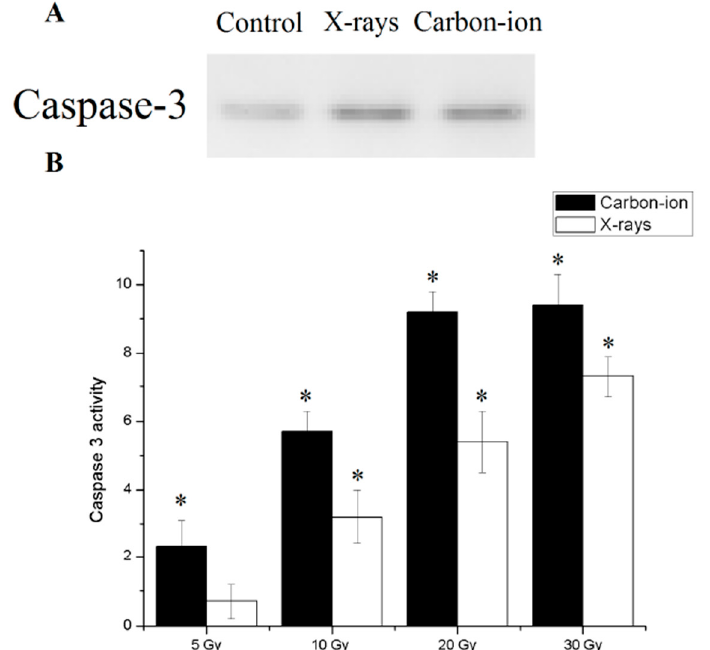
Figure 5. Apoptosis in 30 Gy X-rays and carbon-ion irradiated E. granulosus hydatid cysts. ( A ) Caspase 3 expression in hydatid cysts with and without 30 Gy ionizing radiation. ( B ) Caspase 3 like activity was measured as the difference in pNA production between the samples with and without ionizing radiation. Error bars represent the SD, each done in at least triplicate. * Statistical significant at p < 0.01.